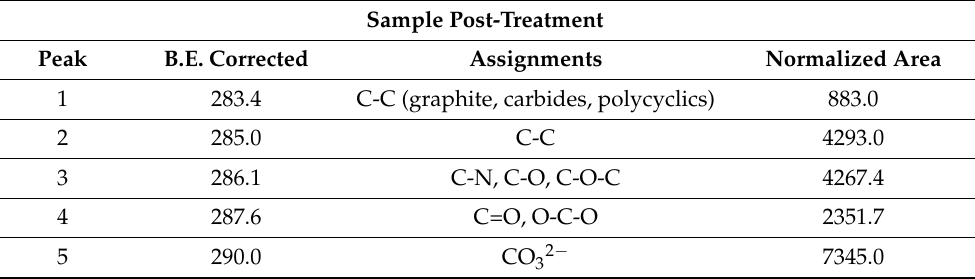
Table 2. Corrected BE, normalized area and assignments for the C1s regions: post-treatment